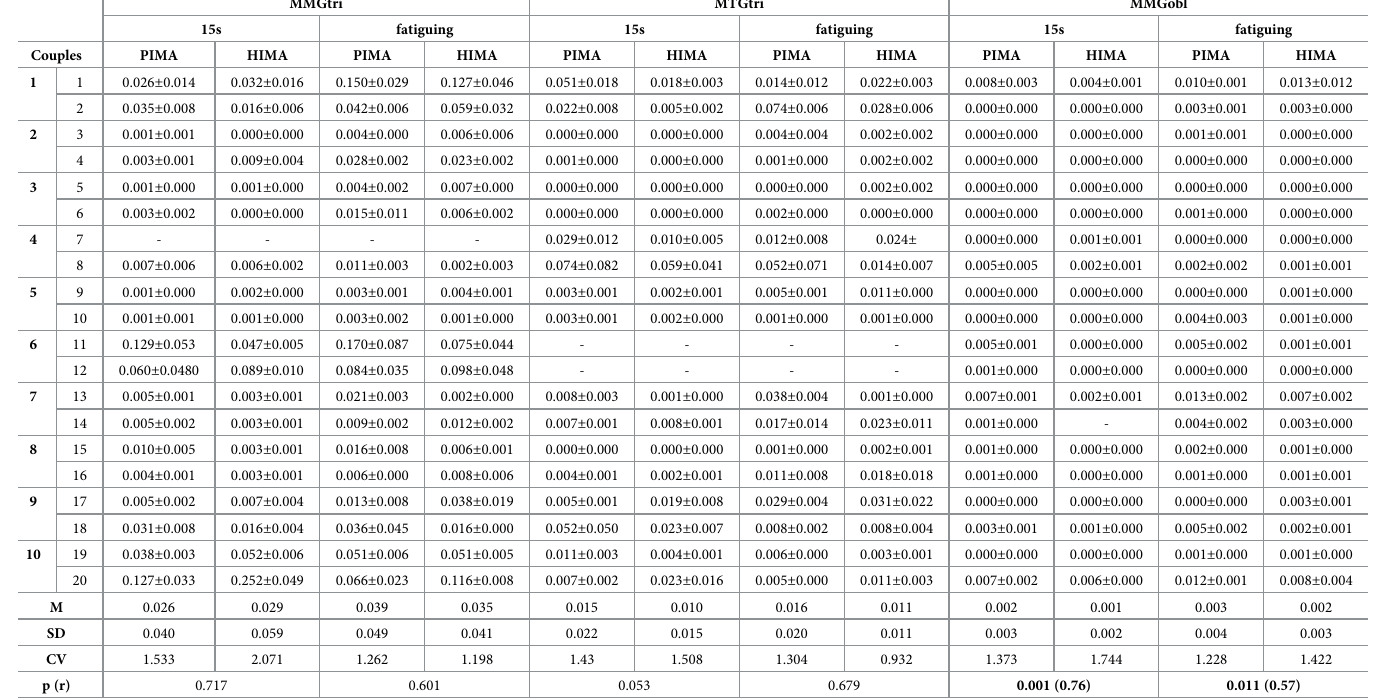
Table 3. Power in frequency ranges from 8 to 15